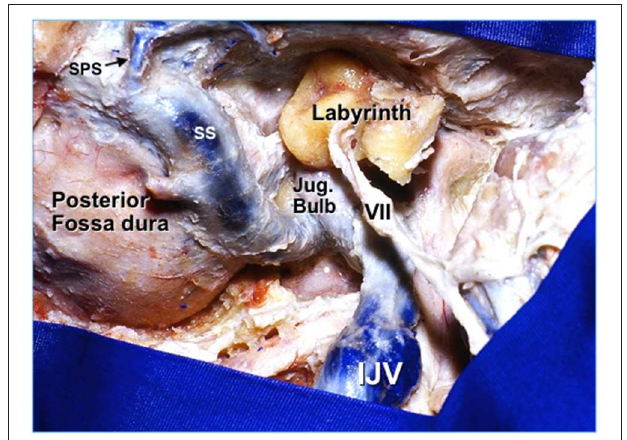
FIGURE 4 | Lateral extradural exposure of a right jugular foramen (3). IJV, internal jugular vein. Jug, jugular. SPS, superior petrosal sinus. SS, sigmoid sinus. VII, facial nerve. [Modified from Ramina and Tatagiba (3)].